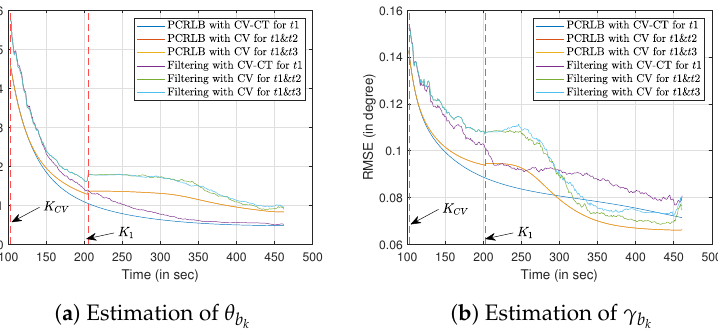
Figure 10. RMSE evaluation for bias estimation using two targets of opportunity with unknown location and terrain uncertainty. The second target of opportunity is located on either side of the sensor